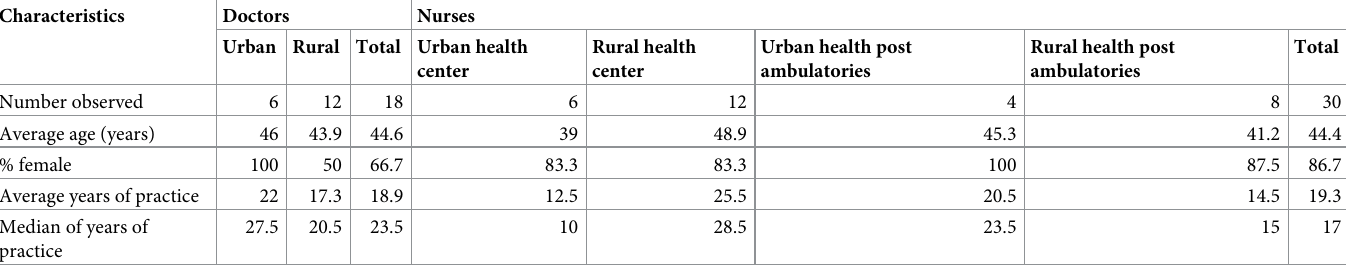
Table 1. Characteristics of the observed staff.